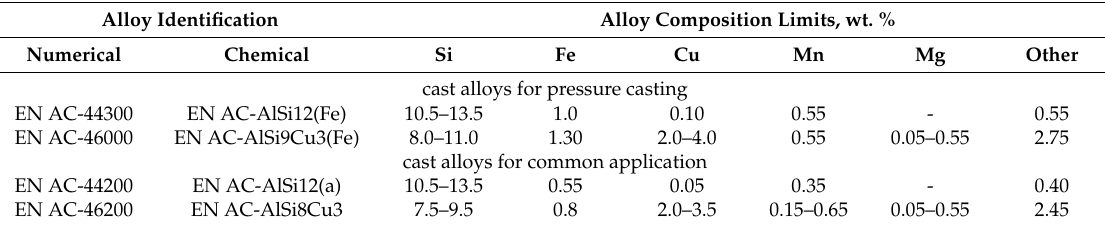
Table 1. Composition of some Al cast alloys, data from